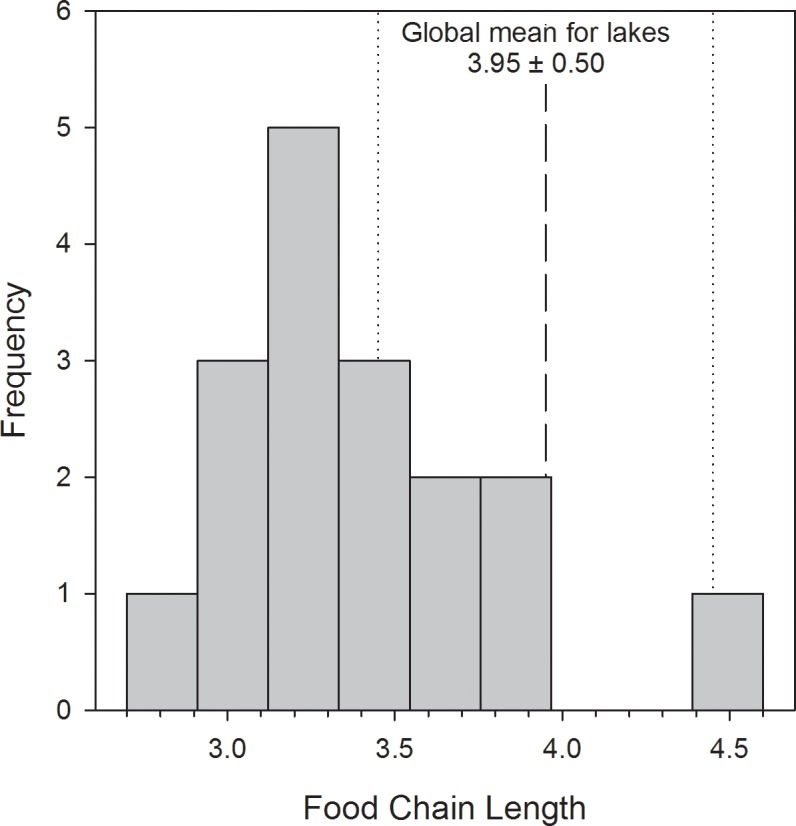
Frequency distribution of FCL measured in THg biomagnification studies for African water bodies.The global mean (± 1 standard deviation) of food chain length in lakes is provided as a reference (Vander Zanden and Fetzer 2007).